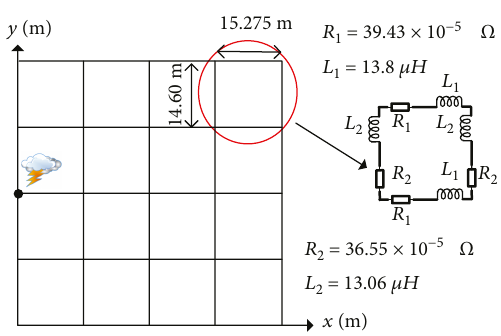
Figure 13: 16-mesh simulation model of regular grounding grid after applying a genetic algorithm.